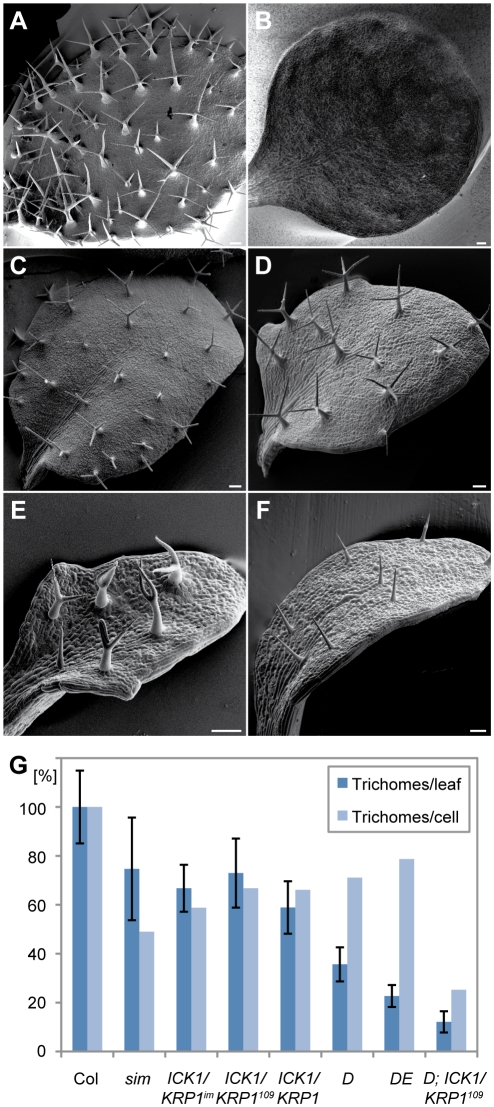
Reduced trichome numbers on plants with altered cell-cycle control in trichomes.Scanning electron micrographs of rosette leaf number 4 of Arabidopsis seedlings. (A) Columbia, (B) PROCPC:CYCD3;1, (C) PROGL2: ICK1/KRP1im, (D) CDKA;1T161D, (E) CDKA;1T14D/Y15E and (F) PROGL2:KRP1109 - CDKA;1T161D plants. (G) Quantification of trichome numbers of leaf 3 and 4 in comparison with Columbia. Col Columbia n = 31. sim siamese n = 18. ICK1/KRP1IM
,
PROGL2:GUS:YFP:KRP1109 n = 30. KRP1109 PROGL2:KRP1109 n = 32. D CDKA;1T161D n = 32. DE CDKA;1T14D/Y15E n = 32. D; ICK1/KRP1109 CDKA;1T161D; PROGL2:KRP1109 n = 26. Error bars: standard deviation. Scale bars: (A–F) 100 µm.